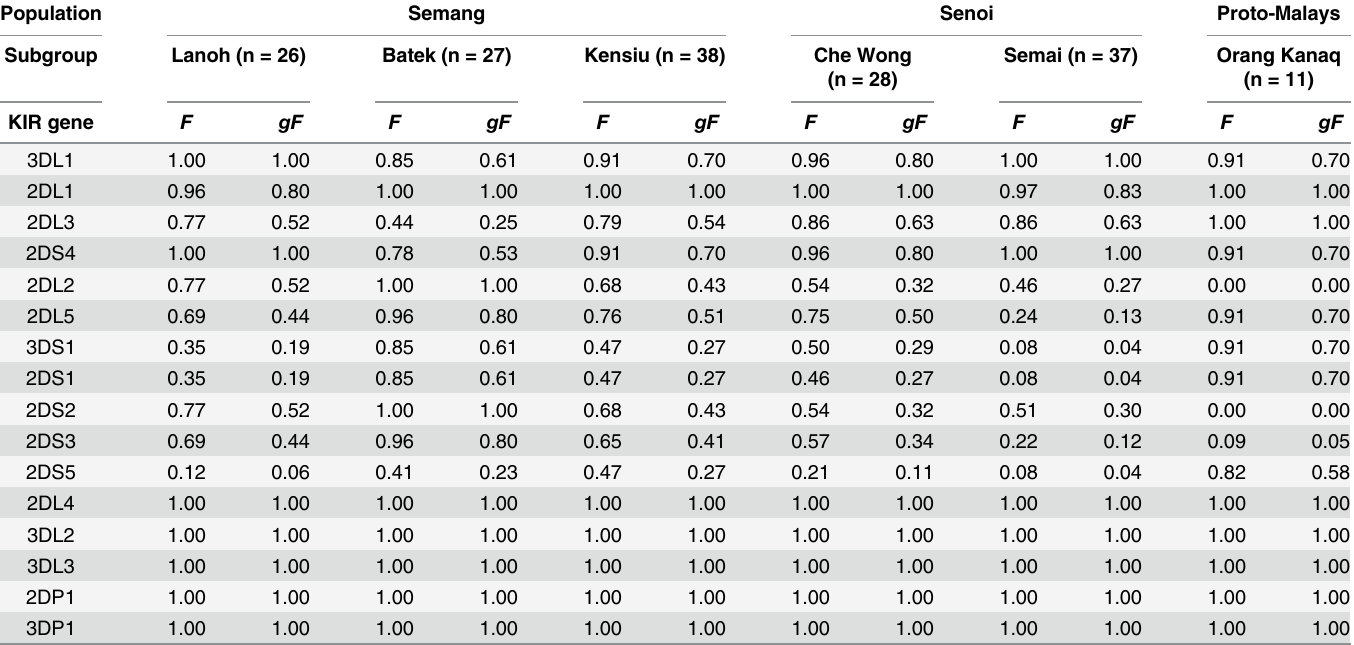
Table 1. Observed ( F ) and estimated ( gF ) KIR genes frequencies for OA subgroups. Population Semang Subgroup Lanoh (n =